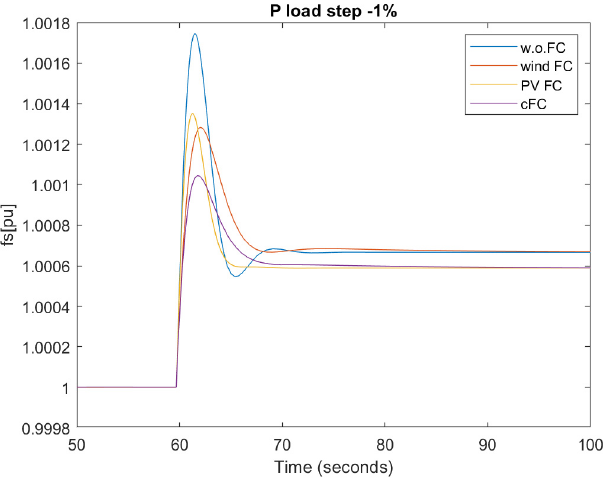
Figure 12. Simulation 2 frequency trend.